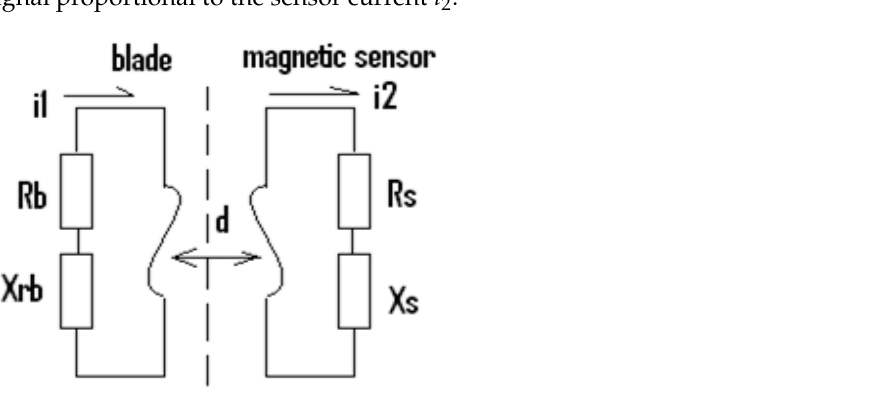
Figure 1. Inductive sensor circuit.